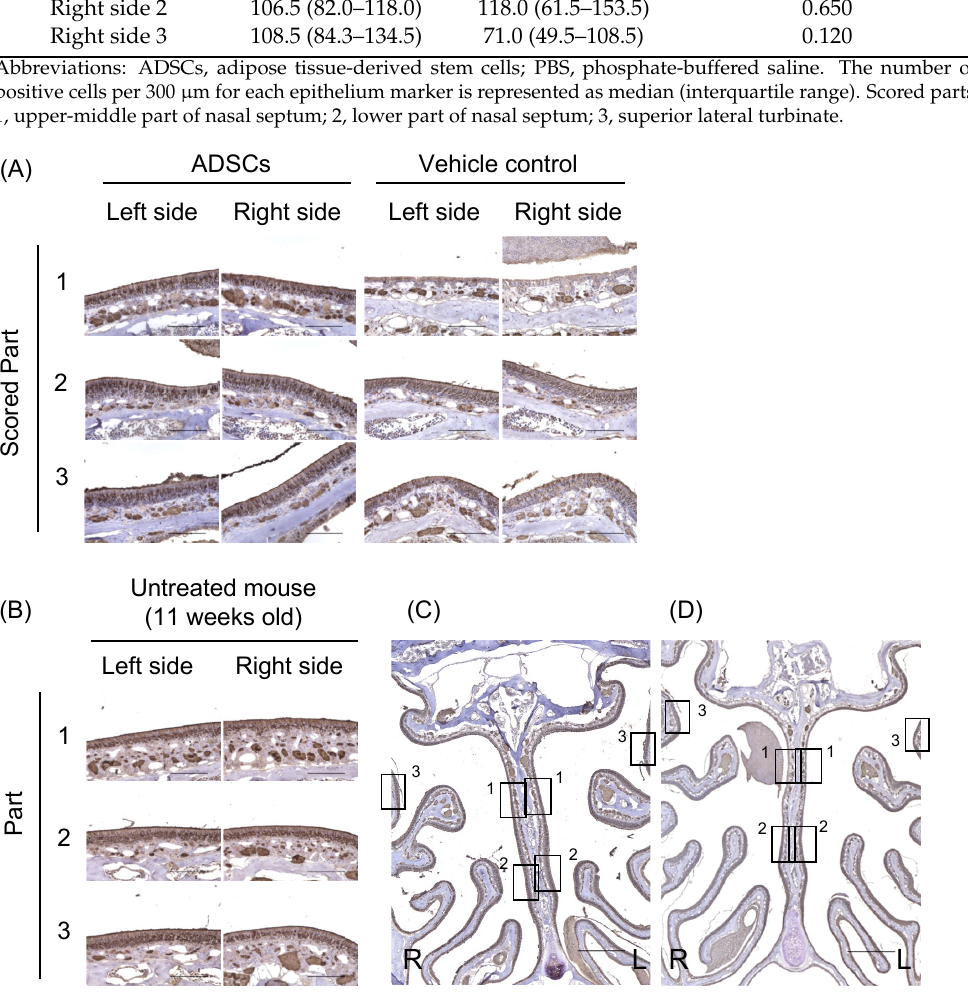
Figure 2. Immunohistochemical analysis of olfactory marker protein in the nasal epithelium of mice 14 d after nasal administration of ADSCs. ( A ) Expression of the olfactory marker protein (OMP) in the olfactory epithelium of mice treated with ADSCs or PBS. Scored Part 1: the left and right side of the upper-middle part of the nasal septum. Scored Part 2: the left and right side of the lower part of the nasal septum. Scored Part 3: the left and right side of the superior lateral turbinate. ( B ) The expression of OMP detected in the middle layer of the nasal septum and turbinate epithelium in an untreated 11-week-old male C57BL/6J mouse. ( C , D ) Squares indicate the parts of an assessment in the lower power field image in the olfactory epithelium of mice treated with ADSCs ( C ) or PBS ( D ). Images are representative of six mice for each treatment group ( A , C , D ), and representative of four untreated mice ( B ). Bars = 100 µm ( A , B ) and 500 µm ( C , D ).